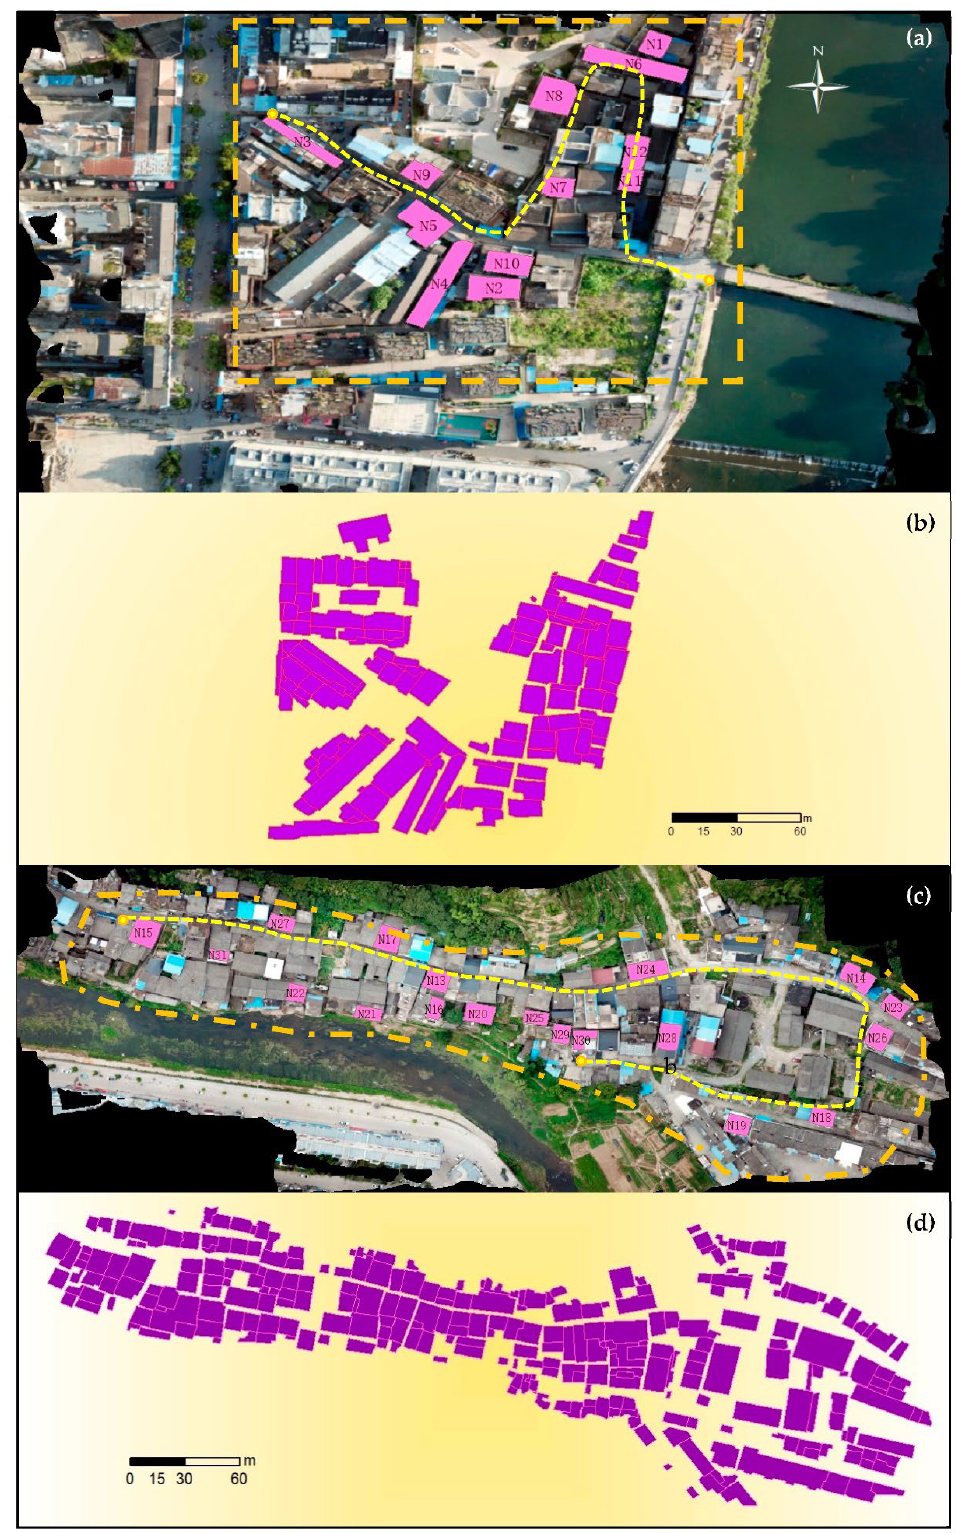
Figure 3. Area of rural homesteads surveyed by questionnaire and unmanned aerial vehicle (UAV) in Zones A and B: ( a ) distribution of rural homesteads surveyed through a questionnaire in Zone A; ( b ) rural homesteads interpreted by UAV in Zone A; ( c ) distribution of rural homesteads surveyed through a questionnaire in Zone B; and ( d ) rural homesteads interpreted by UAV in Zone B. The orange dotted line is the scope of the survey. The yellow dotted line is the questionnaire survey